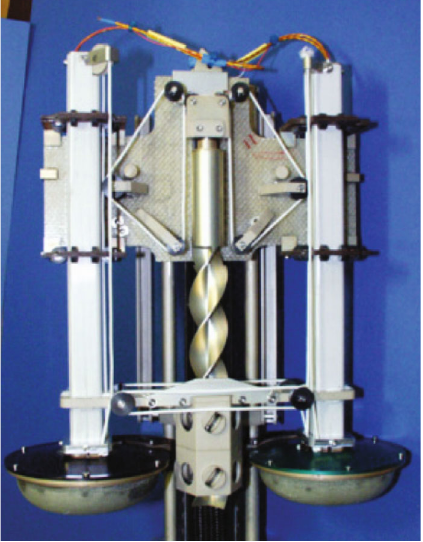
Figure 3: Icy bolt anchoring